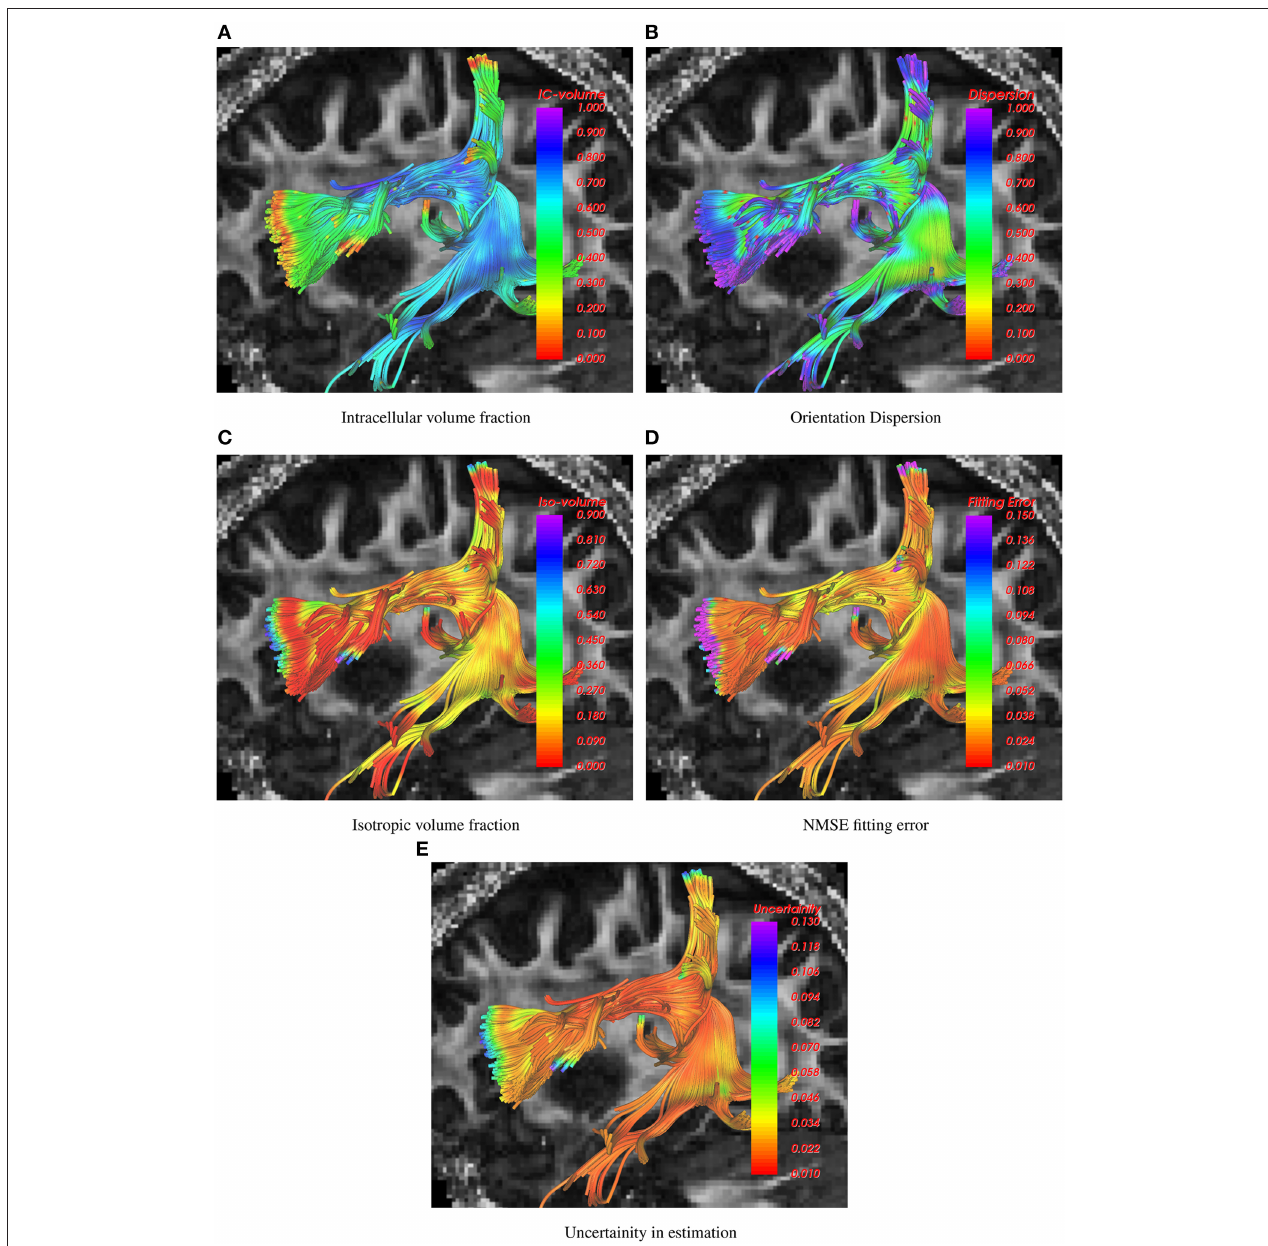
FIGURE 1 | Visualization of intracelluar volume fraction, fiber dispersion, isotropic volume fraction, data fitting error and uncertainity in parameter estimation using 1-fiber noddi model in the arcuate fasciculus. The background slice is the single tensor FA